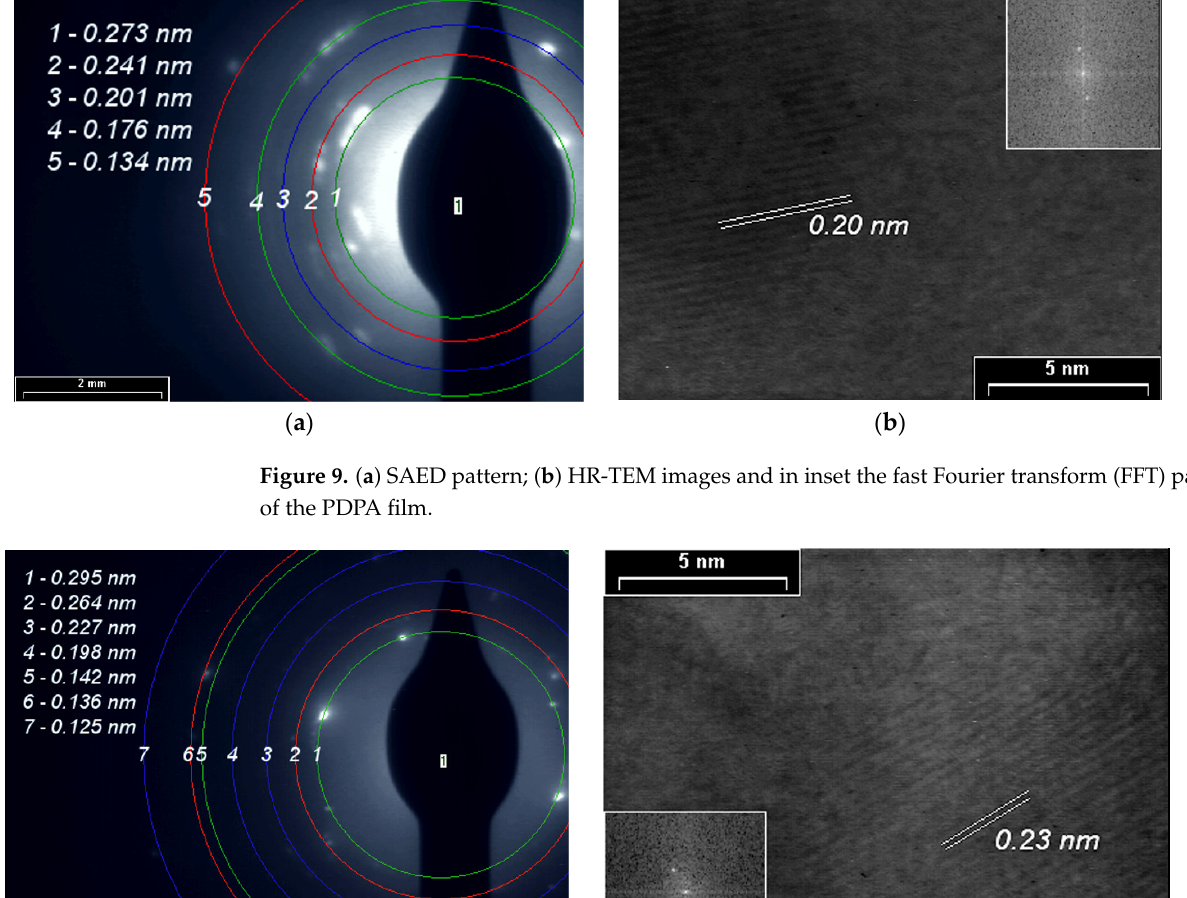
Figure 10. ( a ) SAED pattern; ( b ) HR-TEM images and in inset the fast Fourier transform (FFT) pat- tern of the PPAni-PDPA film.